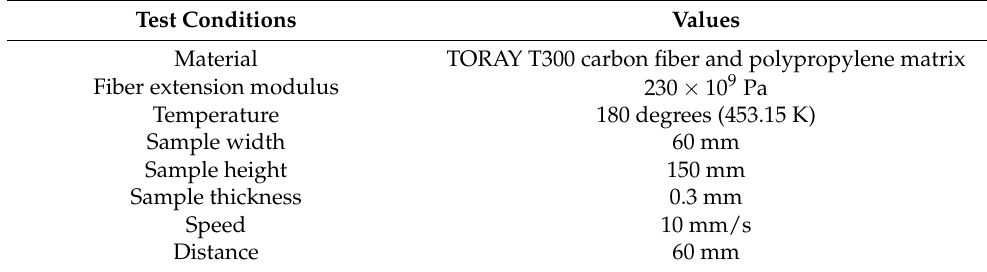
Table 2. The bias-extension test